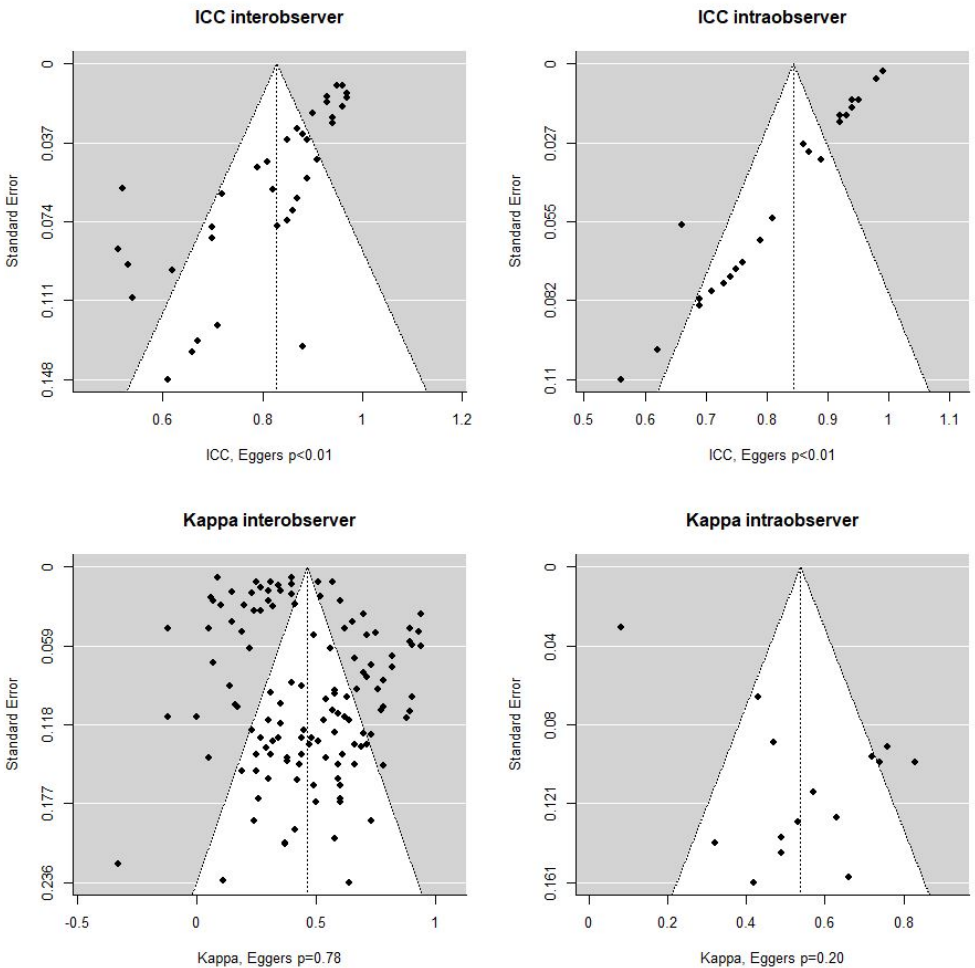
Figure 5 . Eggers tests for inter/intra-observer agreements (ICC and Kappa models). Figure 5. Eggers tests for inter/intra-observer agreements (ICC and Kappa